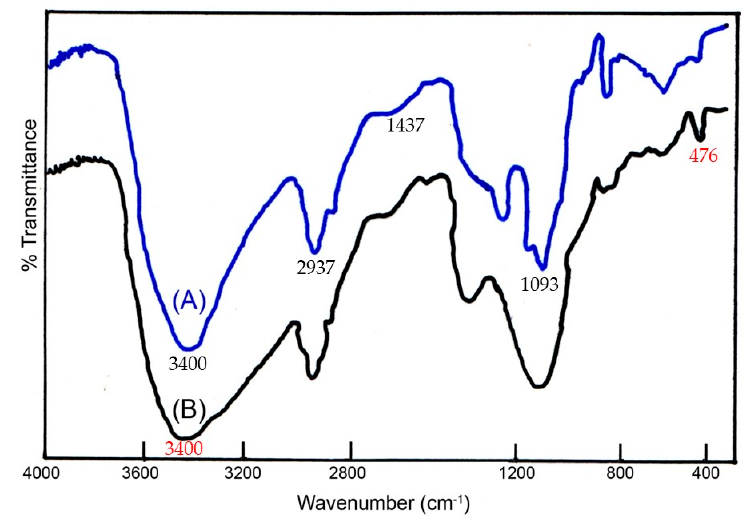
Figure 3. FTIR tracings of ( A ) Plain PVA and ( B ) PVA ‐ ZnO membranes.